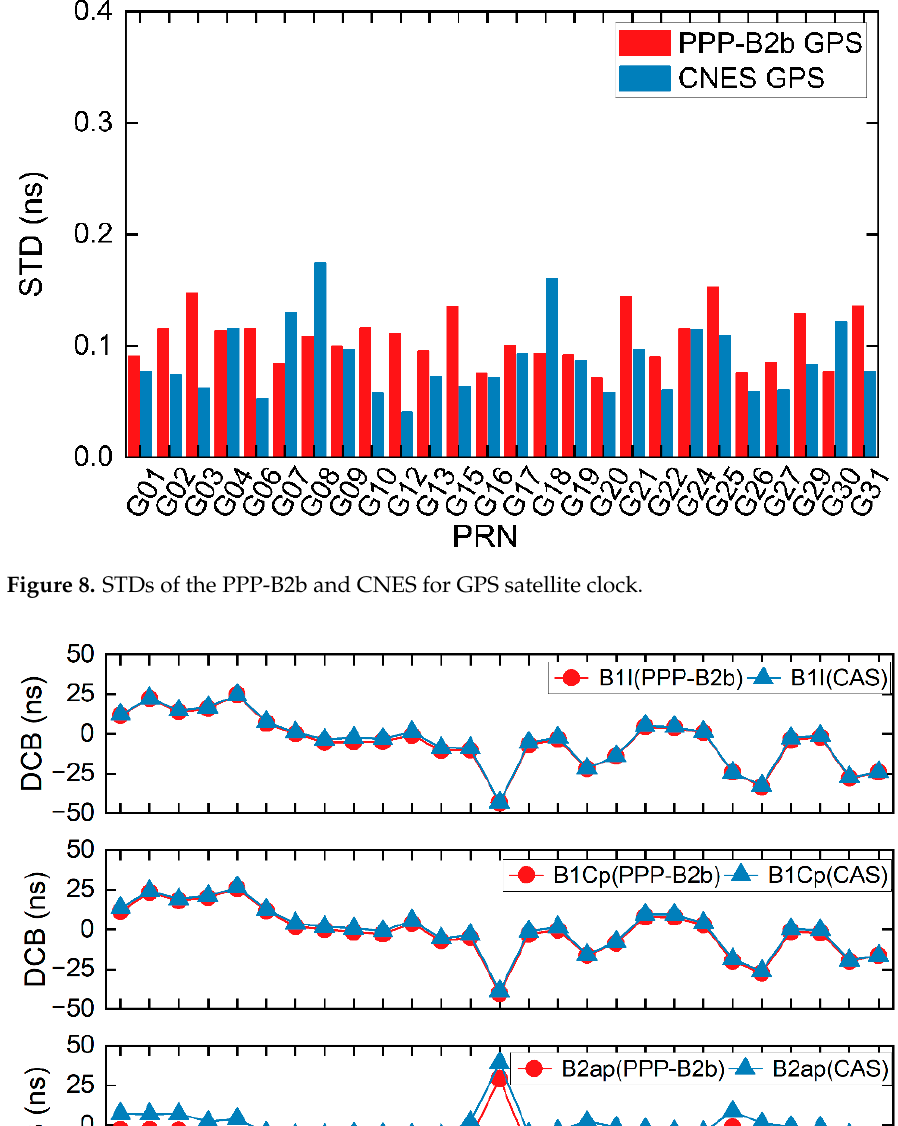
Figure 8. STDs of the PPP-B2b and CNES for GPS satellite clock.